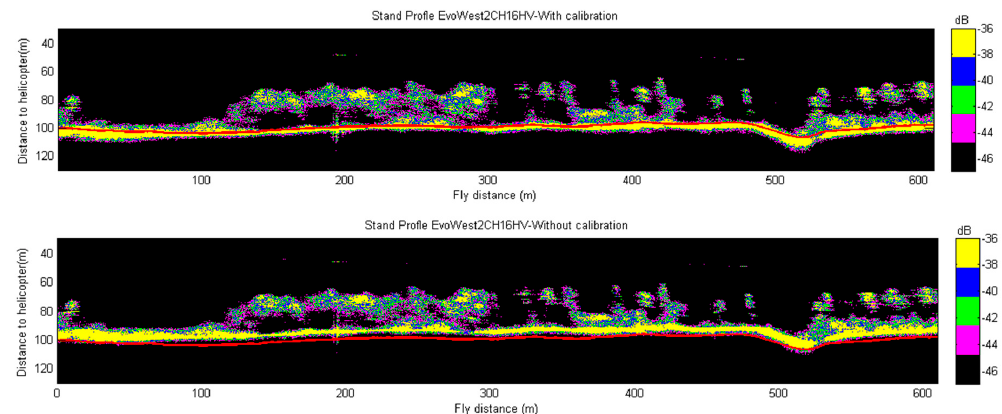
Figure 8. Range-calibrated ( upper ) and non-calibrated ( lower ) stand profiles created during the test; the red lines represent the ground level acquired from DEM.